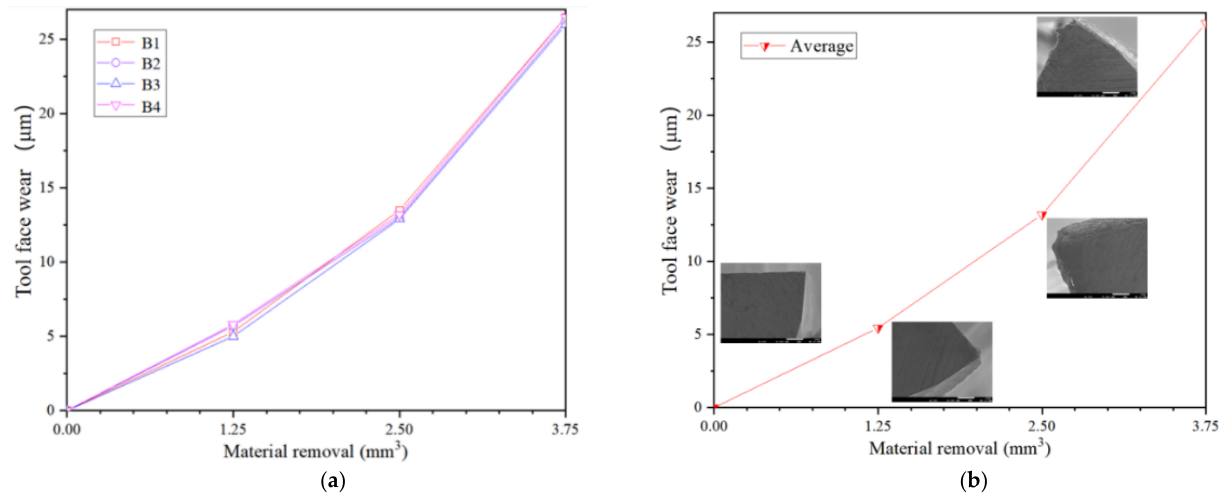
Figure 11. Effect of material removal volume on tool face wear in micro milling Ti-6Al-4V. ( a ) Tool face wear of different cutting edges; ( b ) the average amount of tool face wear.